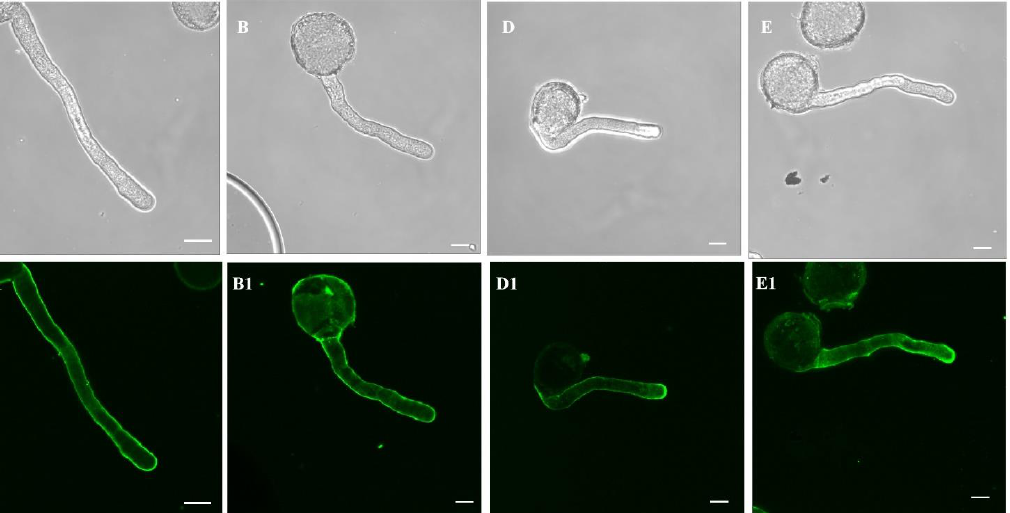
Figure 5. Effect of 20 µM AlCl 3 on pectin distribution of pollen tube wall of M. domestica. ( A ) Bright- field image of a control pollen tube. ( A1 ) Acid pectins of the control pollen tube in A labeled with JIM 5 under CLSM. ( B ) Bright-field image of a pollen tube treated with 20 µM AlCl 3. ( B1 ) Acid pec- tins of the pollen tube in B. ( C ) Quantitative analysis of the fluorescent intensity of acid pectins (JIM 5) in the wall of control (blue line) and 20 µM AlCl 3 (red line) pollen tubes. ( D ) Bright-field image of a control pollen tube. ( D1 ) Esterified pectins of the pollen tube in D labeled with JIM 7 under CLSM. (E) Bright-field image of a pollen tube treated with 20 µM AlCl 3. ( E1 ) Esterified pectins of the pollen tube in E. ( F ) Quantitative analysis of the fluorescent intensity of esterified pectins of control (blue line) and 20 µM AlCl 3 treated (red line) pollen tubes. Bar = 10 µm. LM6 could label (1 → 5)- α -L-arabinan, a structural feature of the side chains of pectins [22]. To specify how much pectin epitopes are involved in pollen tube growth, the anti- body (LM 6) was used to label arabinan pectins. Arabinan pectins was distributed on both the control and the 20-µM-AlCl 3 -treated pollen tube walls. At the tip of the pollen tube, stronger fluorescence was observed on the 20- μM -AlCl 3 -treated pollen tube (Figure 6B1). Thus, 20 μM AlCl 3 increased arabinan pectins in pollen tubes.